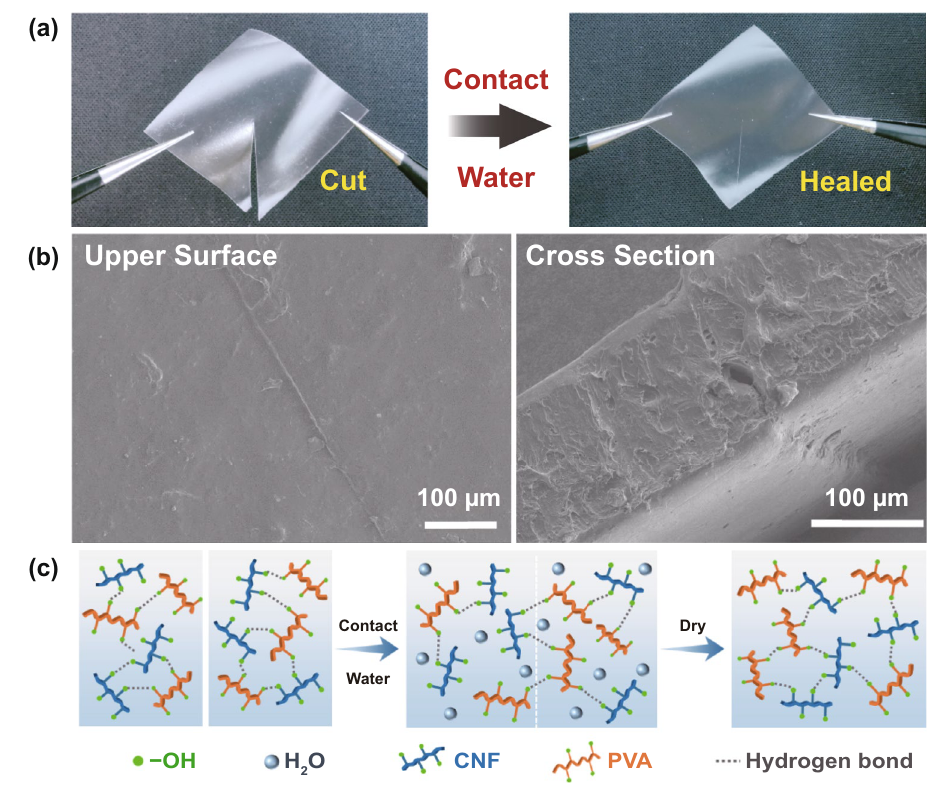
Fig. 1 a Photographs of damaged CNF/PVA film (left) and self-healed CNF/PVA film (right). b SEM images of upper surface (left) and cross section (right) of self-healed position on CNF/PVA film. c Schematic illustration of the moisture-inspired self-healing mechanism of CNF/PVA